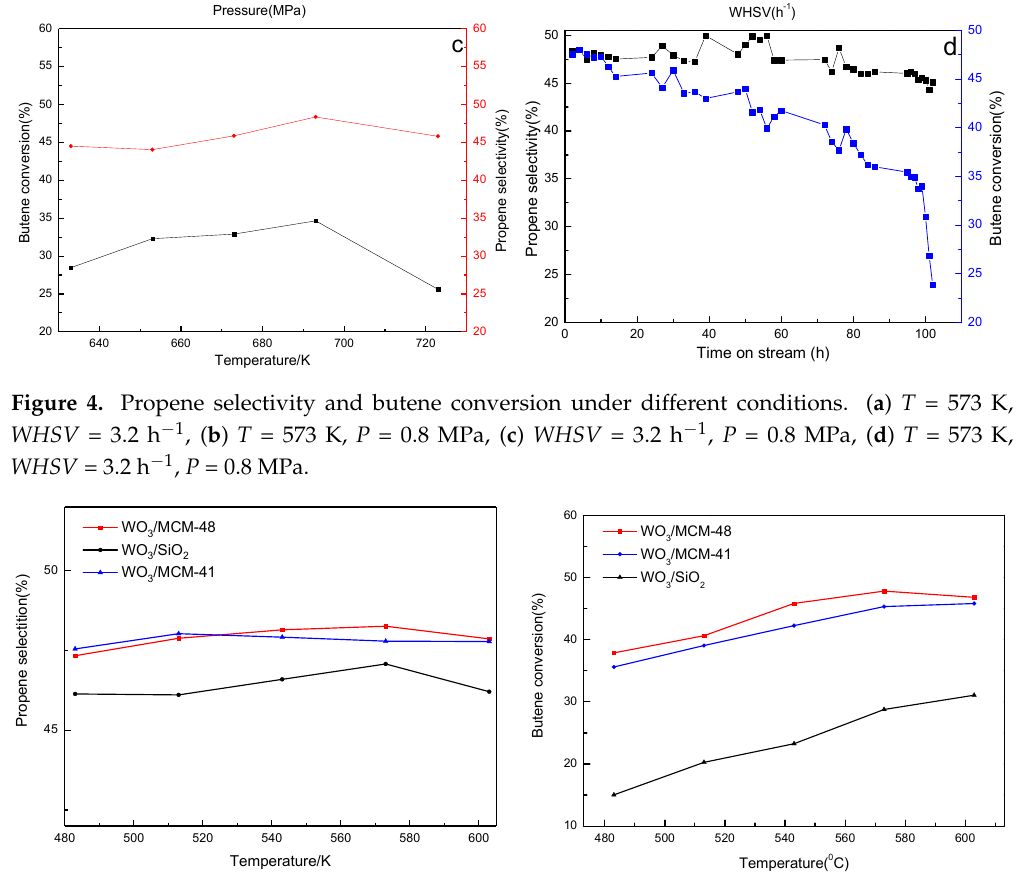
Figure 5. Propene selectivity and butene conversion over catalysts. Reaction conditions: WHSV = 3.2 h −1 , P = 0.8 Mpa.